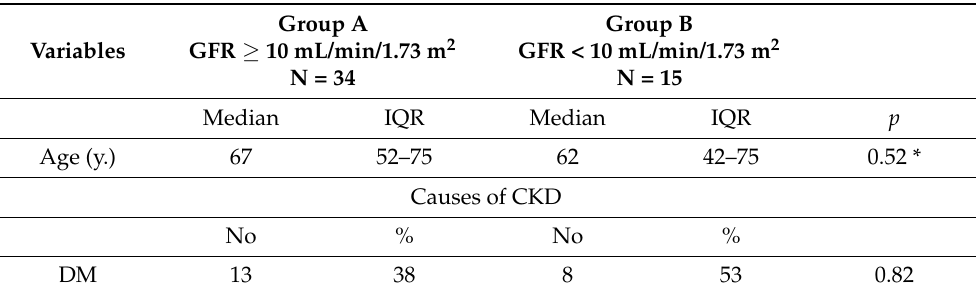
Baseline characteristics of the study group and comparison between Group A (GFR ≥ 10 mL/min/1.73 m 2 ) and Group B (GFR < 10 mL/min/1.73 m 2 ). Group Variables